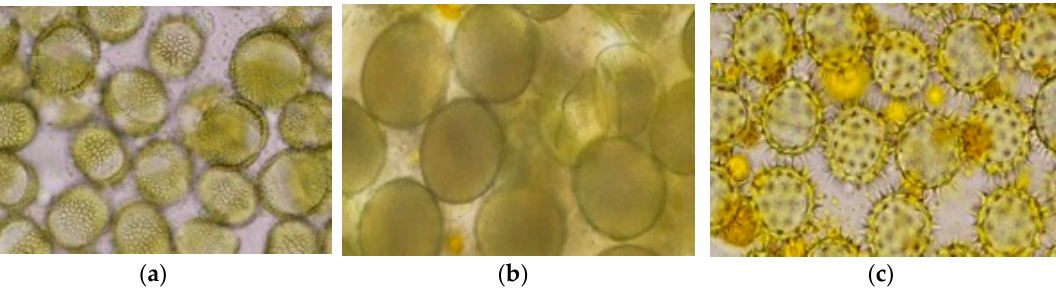
Figure 3. Microscopic view of the pollen grains used to confirm the studied selected samples. ( a ) The oilseed rape ( Brassica napus ) pollen had a ~24 µm grain with a round tricolpate form and grooves at the rounded tip, covered with a membrane, sometimes with small granular residues; the exine had a finely cross-linked surface. ( b ) The corn ( Zea mays ) pollen grain was a ~99 µm granule with a single porous opening, the exine and the intine being thin membranes and the cytoplasm appearing granular with numerous small starch formations. ( c ) The sunflower ( Helianthus annuus ) pollen grain was ~35 µm and was a trickled grain, having a surface covered in thin and long thorns that protruded to the pores. The used equipment: Olympus, Quick Photo camera 3.1., ×200: Photos© Institute for Beekeeping Research and Development, Bucharest.